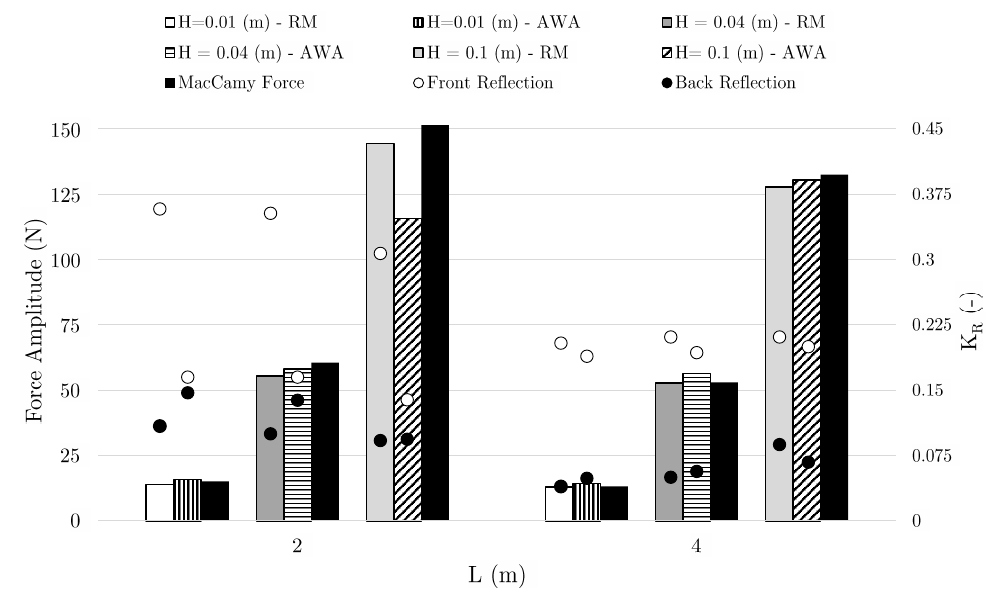
Figure 11. Force amplitudes and reflection coefficients at the front and at the back of the